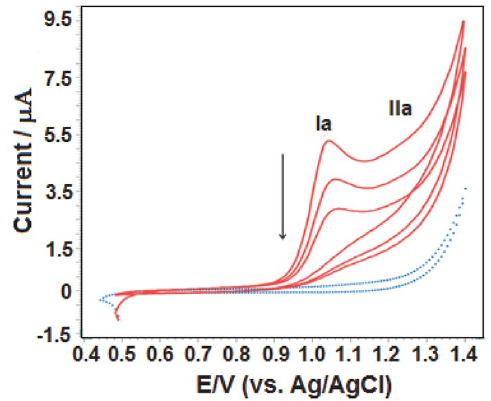
Figure 3. The repetitive cyclic voltammograms of 2.4 × 10–5 M pantoprazole in BR buffer, pH 7.0 at scan rate of 100 mV s –1 . Elec- trode, PGE. Dashed lines represent background